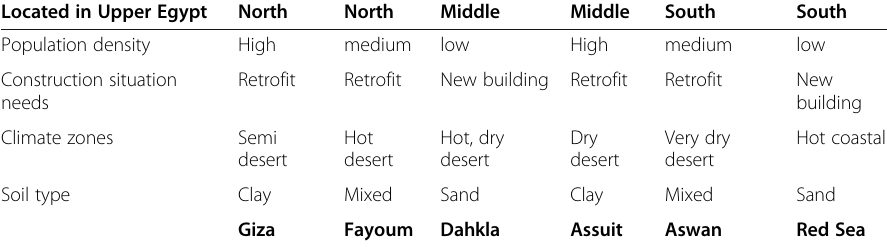
Table 4 Data of case study areas